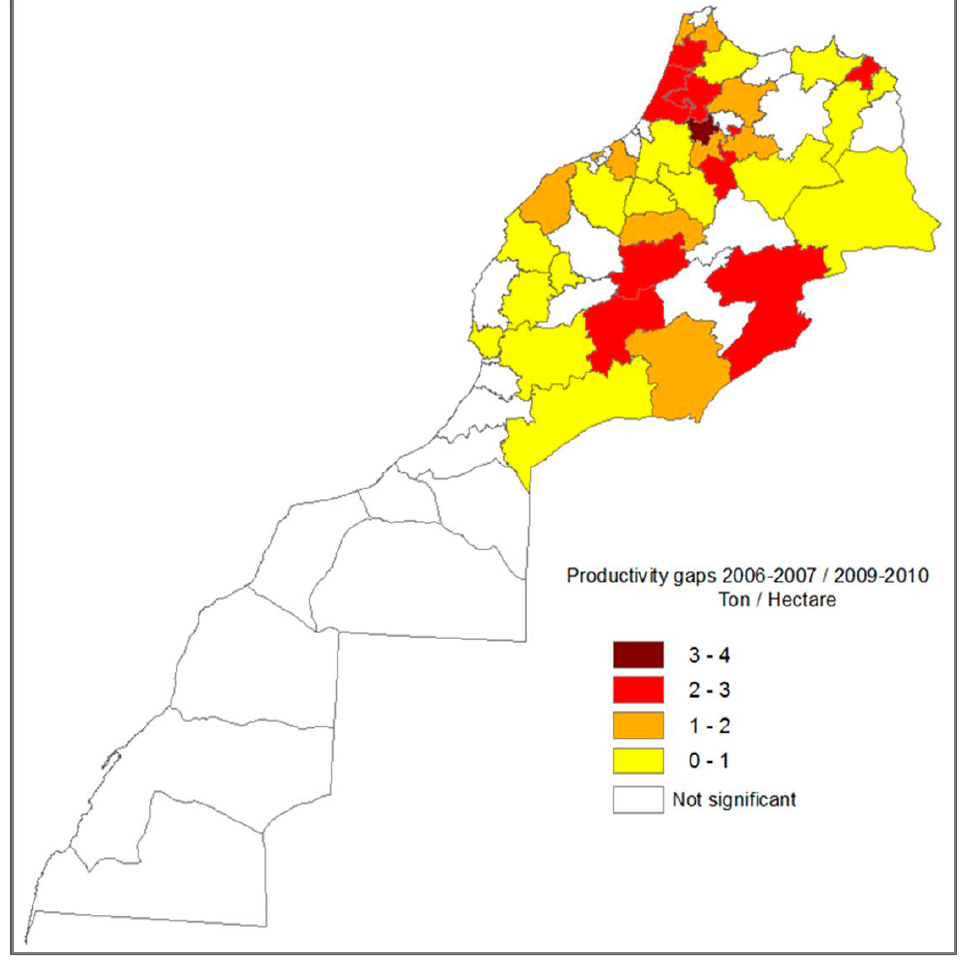
Figure 6. Cereal productivity gaps between 2006–2007 and 2009–2010 growing